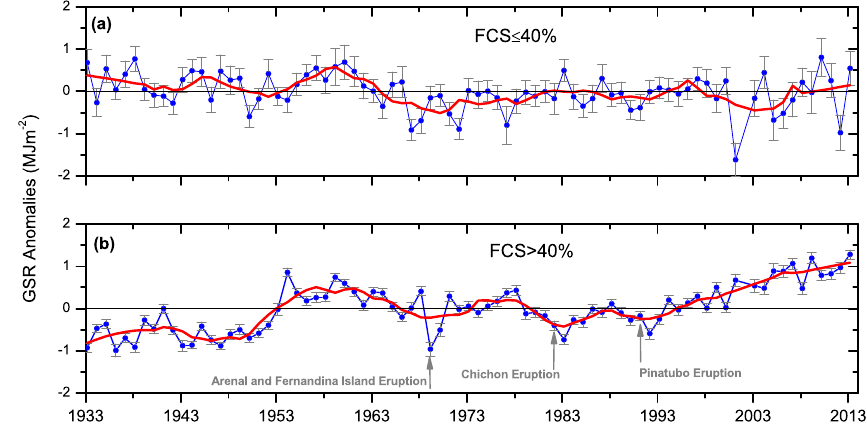
Figure 7. Time series of the GSR anomalies annual means as a function of (a) FCS ≤ 40% (cloud conditions; 13% days) and (b) FCS > 40% (cloud-free conditions; ∼ 90% days) from 1933 to 2013 at IZO. The error bars indicate ± 1SEM (standard error of the mean). Five-year moving average is shown in red. The arrows indicate the eruptions of Arenal and Fernandina Island (1968), Chinchón (1982) and Pinatubo